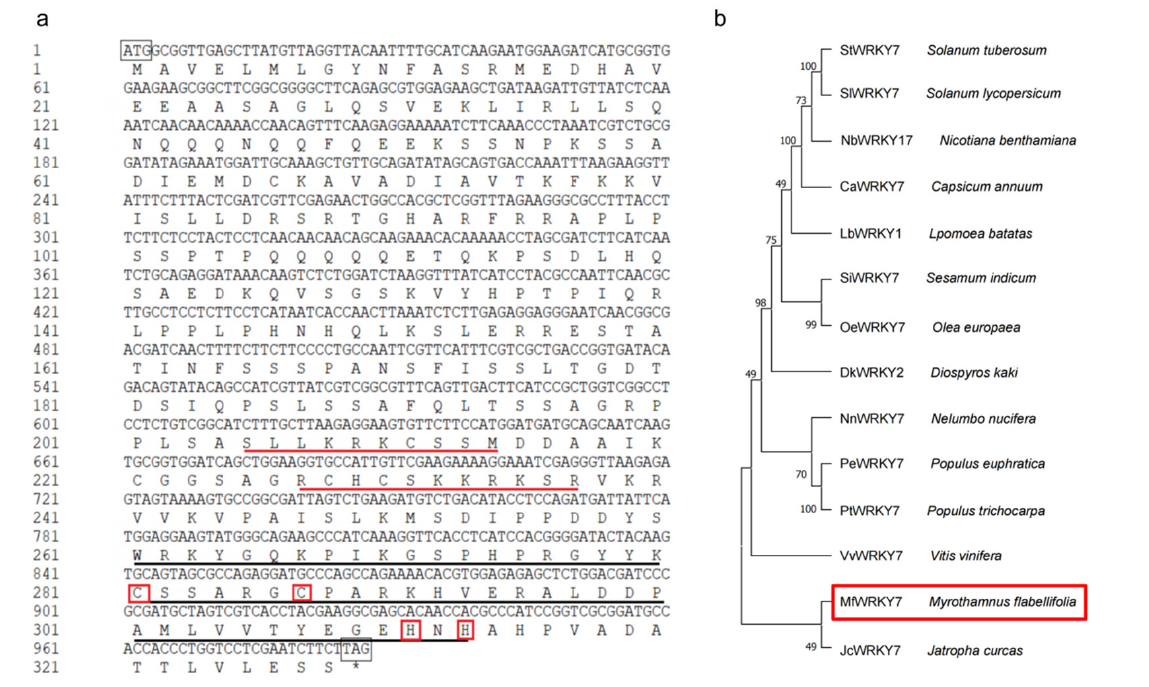
Figure 1. Sequence analysis of MfWRKY7. ( a ) The nucleotide and deduced amino acid sequences of MfWRKY7. Black boxes represented start codons and stop codons (also indicated by *), black line represented WRKY domain, red boxes represented zinc finger structure, and red line represented nuclear location signal, respectively. ( b ) Phylogenetic tree constructed using neighbor-joining method. MfWRKY7 was indicated by a red box. The GenBank accession numbers for the sequences used are listed in Supplementary Table S1.